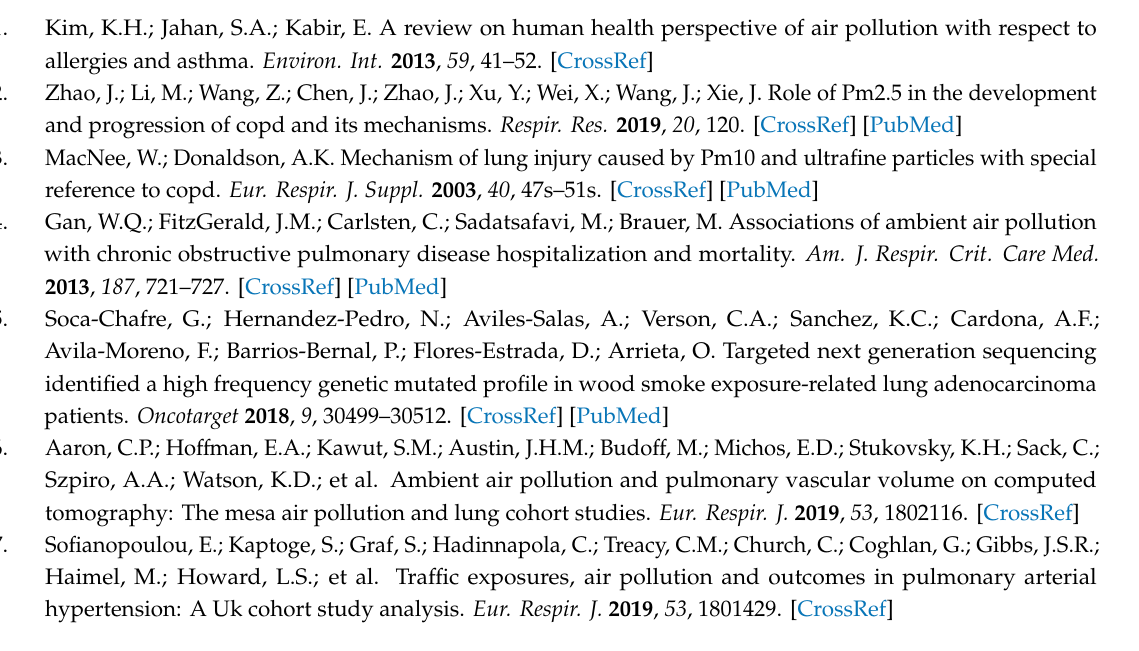
Supplemental Table S1: All SearchResults; Supplemental Table S2: Search Results After 10 Year Filter; Supplemental Table S3: Full Text Articles that were Reviewed Author Contributions: All authors made substantial contributions to the study and manuscript